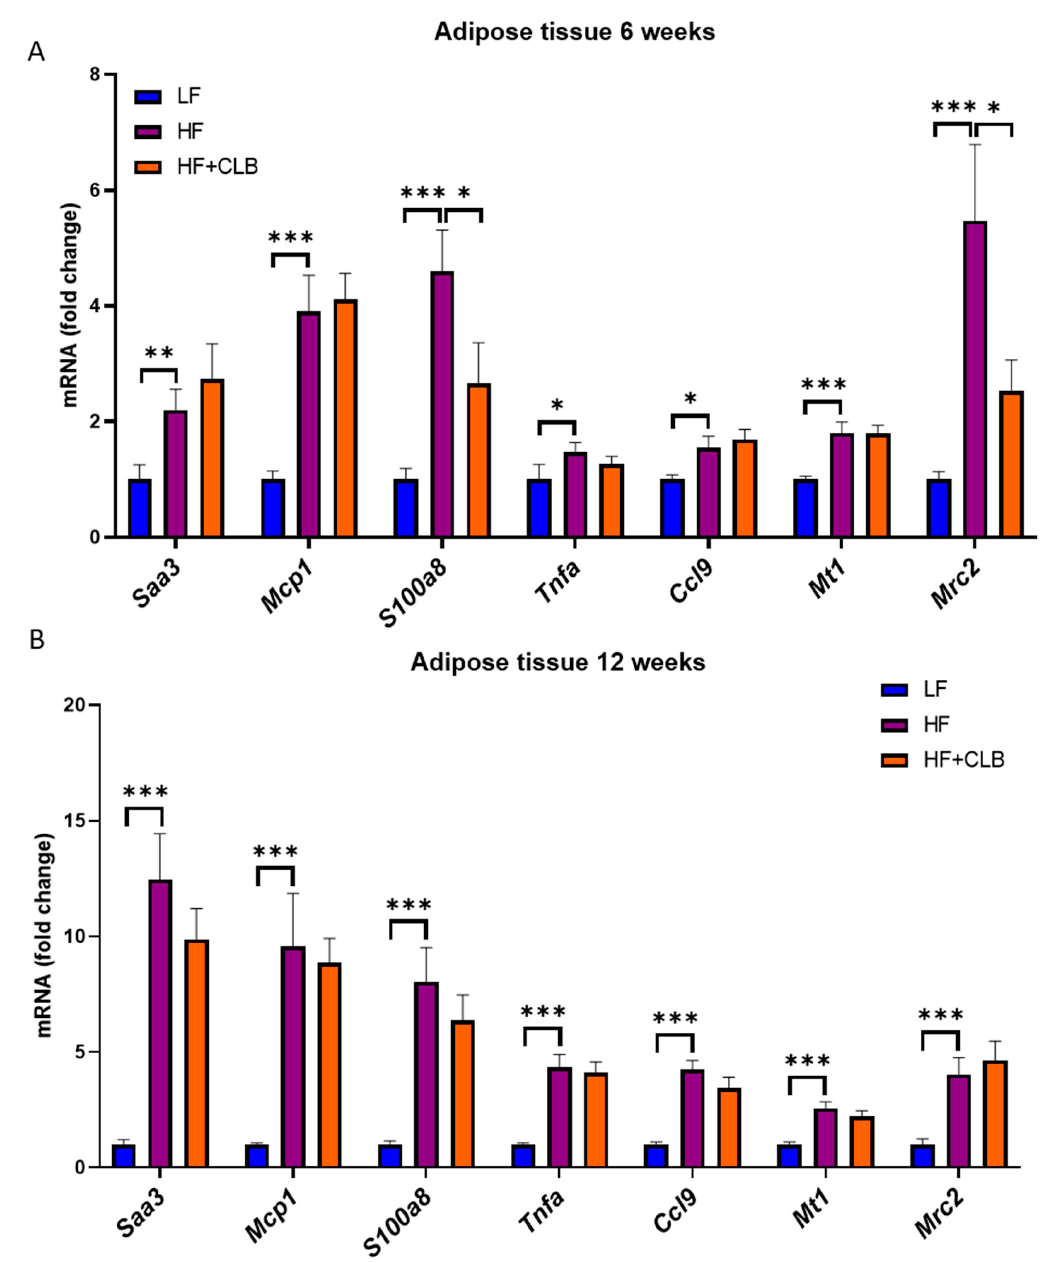
Figure 4. Inflammation-related factors expressed in the adipose tissue. Mice were divided into six groups to receive either a low-fat diet (10% of energy from fat, LF), high-fat diet (46% of energy from fat, HF), or cloudberry-supplemented high-fat diet (HF+CLB) for six or twelve weeks. The gene expression of inflammation-related factors in the epididymal adipose tissue at weeks six ( A ) and twelve ( B ) is expressed as fold change relative to the LF group, which was set as 1. The expression levels were measured with RT-PCR and normalized to glyceraldehyde 3-phosphate dehydrogenase ( Gapdh ). The data were analyzed with one-way ANOVA and Bonferroni post-test, * p < 0.05, ** p < 0.01, and *** p < 0.001. The values represent mean ± SEM, n = 12 mice per group. Saa = serum amyloid A Mcp1 = monocyte chemoattractant protein 1; S100a = S100 calcium-binding protein A; Tnfa = tumor necrosis factor α ; Ccl9 = chemokine (C-C) motif ligand 9; Mt1 = metallothionein 1; Mrc2 = mannose receptor C type 2.